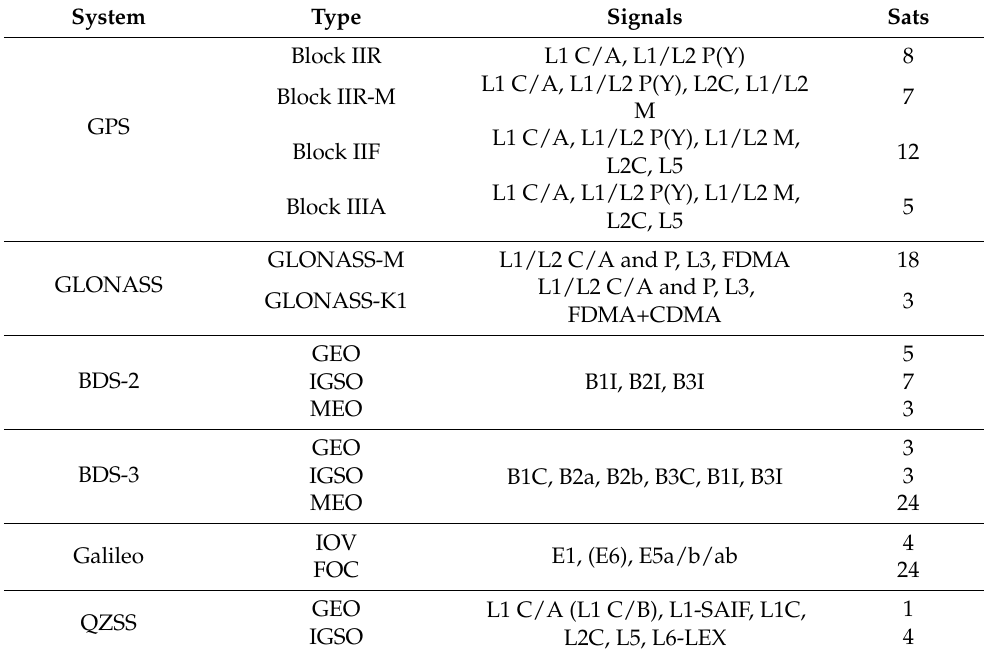
Table 1. Operational status of the GNSS constellations as of July 2022. System Type Signals Sats Block GPS